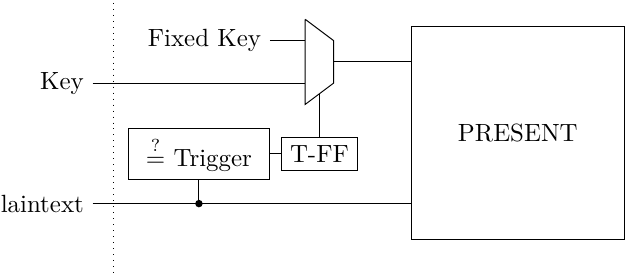
Figure 4: Visualization of the Trojanized PRESENT